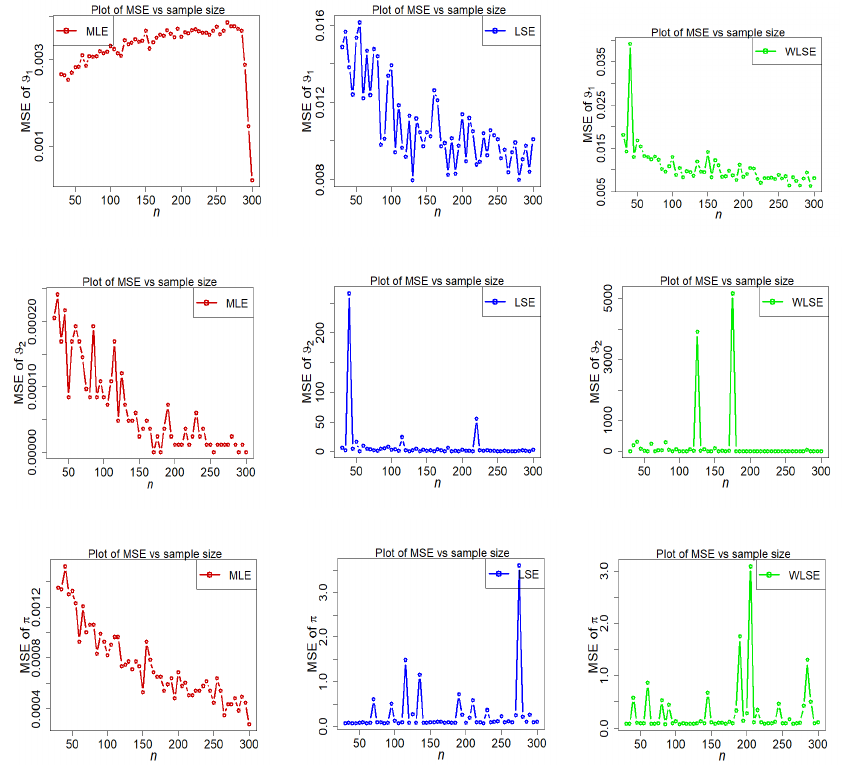
Fig. 14. Fluctuations of MSE of estimators under di⁄erent methods for parametric set IV. The estimated bias of parameters # 1 ;# 2 ;(cid:25) , decreases as n increases under all three estimation (cid:15)